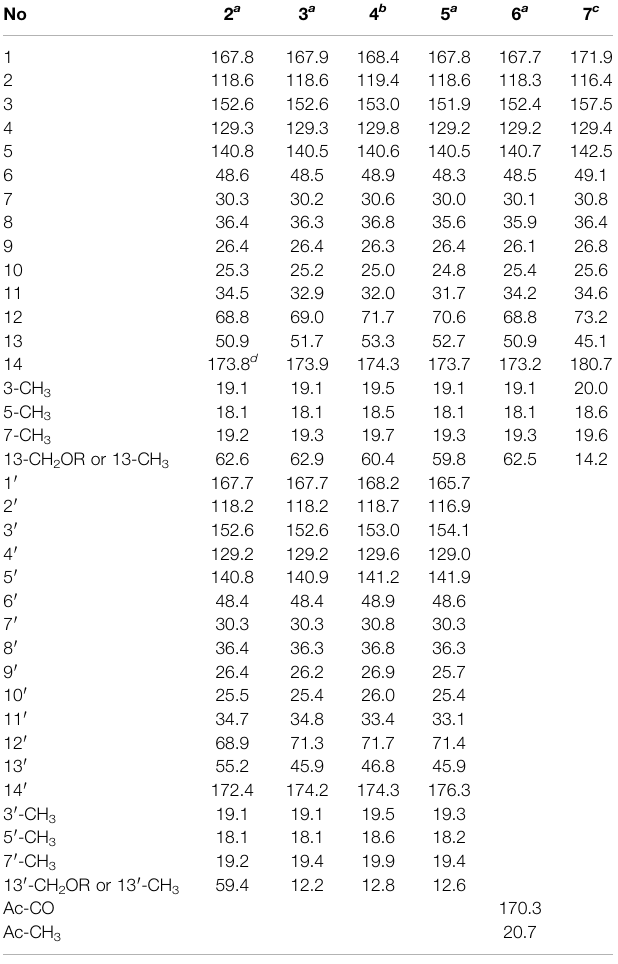
TABLE 2 | 13 C NMR Data of Compounds 2 – 7 ( δ in ppm).